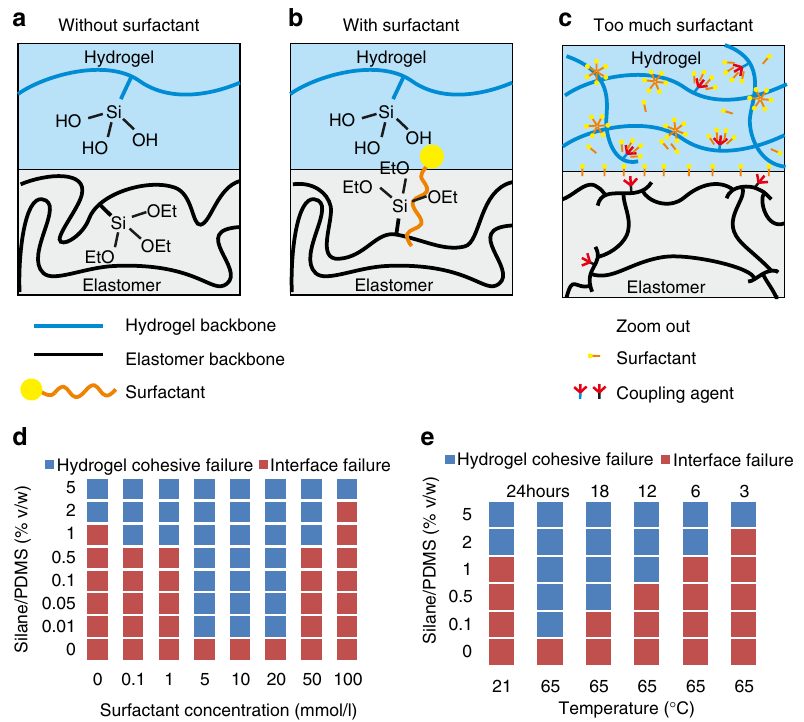
Fig. 5 Effects of surfactant and temperature on adhesion. a The pre-hydrolysis trialkoxysilane on the elastomer chains is hydrophobic, and is hard to stick into the hydrogel. b The surfactant moves to the hydrogel – elastomer interface, and helps the trialkoxysilane on the elastomer chains hydrolyze and condensate. c When too much surfactant is added into the hydrogel, the surfactant – polymer complex covers the relatively hydrophobic coupling agent, which slows down the condensation reaction. d We use a matrix of peeling tests to study how the surfactant affects the amount of the coupling agent in the elastomer needed for strong adhesion. Bonding is considered successful if the peeling test causes a fracture inside the hydrogel, rather than on the hydrogel – elastomer interface. The default recipe uses 10 mmol/l SDS. e Higher temperature speeds up the bonding and reduces the amount of required coupling agent in the